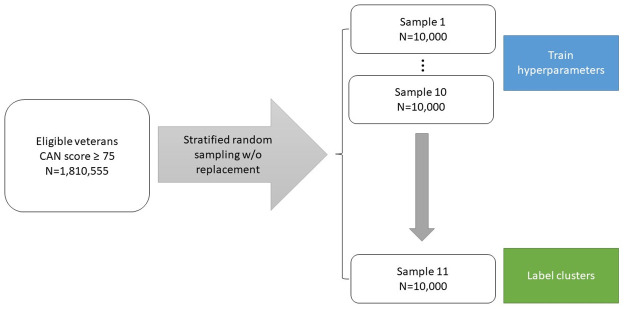
Study schematic.